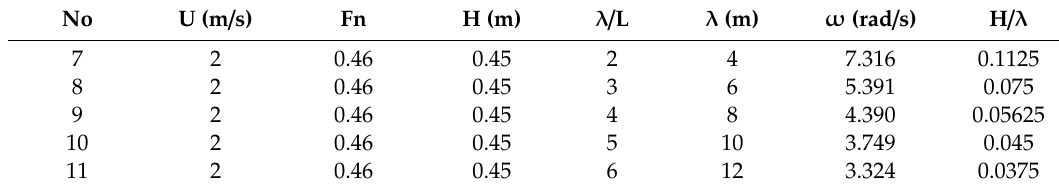
Table 11. The matrix of regular wave with large wave height.